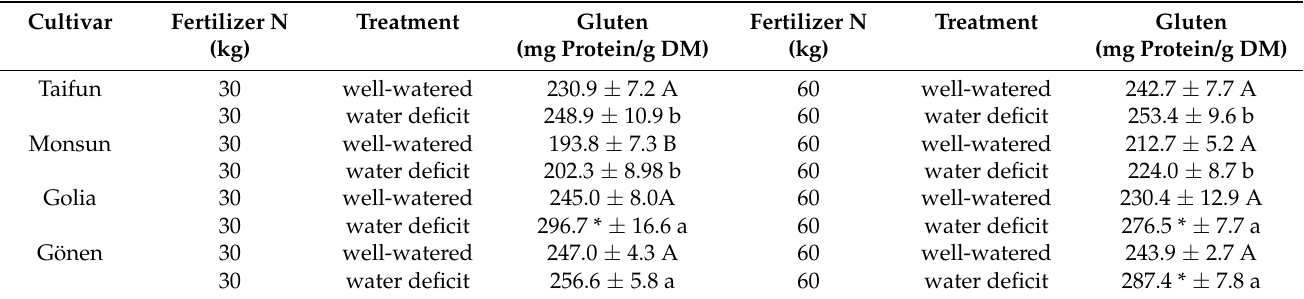
Table 1. Protein content in gluten (mean ± SE mg protein/g DM) at maturity of spring wheat cultivars influenced by N fertilization of 30 or 60 kg N applied at beginning of heading (EC 51) of well-watered and water deficit plants, with the beginning at the end of heading (EC 59) for 21 days (for each N level: well-watered plants: different capitals indicate significant differences between cultivars, Tukey HSD test, p = 0.05, n = 3; water deficit plants: different small letter indicates significant differences between cultivars, Tukey HSD test, p = 0.05, n = 3, * indicates significant difference between well-watered and water deficit plants, Student’s t